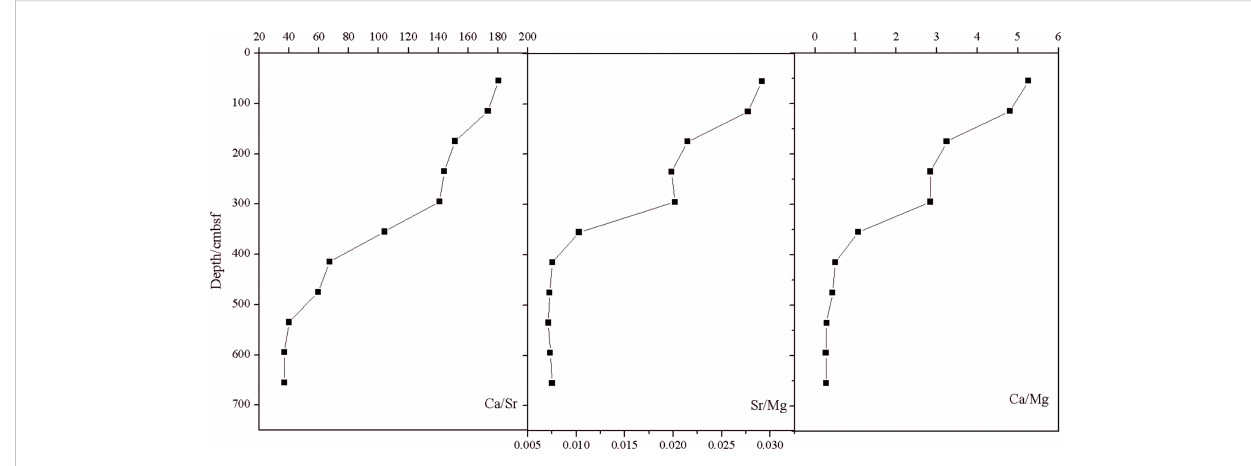
FIGURE 14 Sr/Ca vs Mg/Ca in the sediments. The values of aragonite, biological calcite, calcite and detrital fraction are derived from Yang et